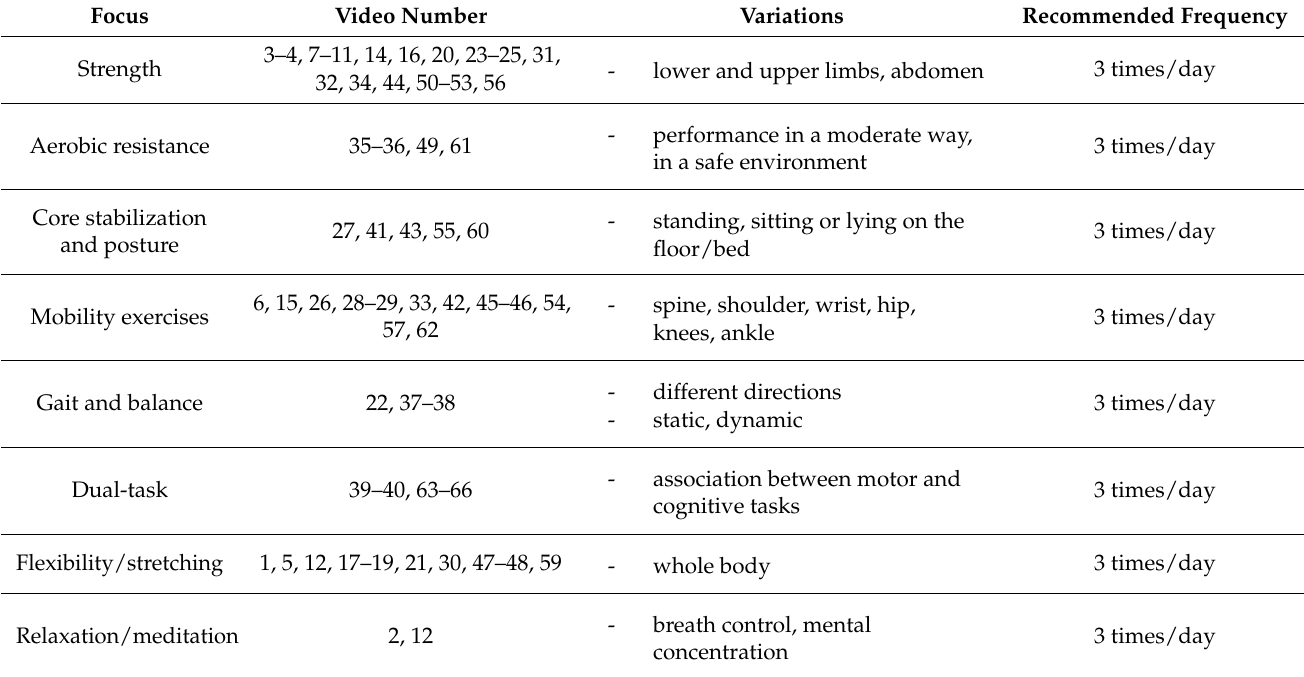
Table 1. Physical exercises offered by the “U3A in Motion” program for video home training